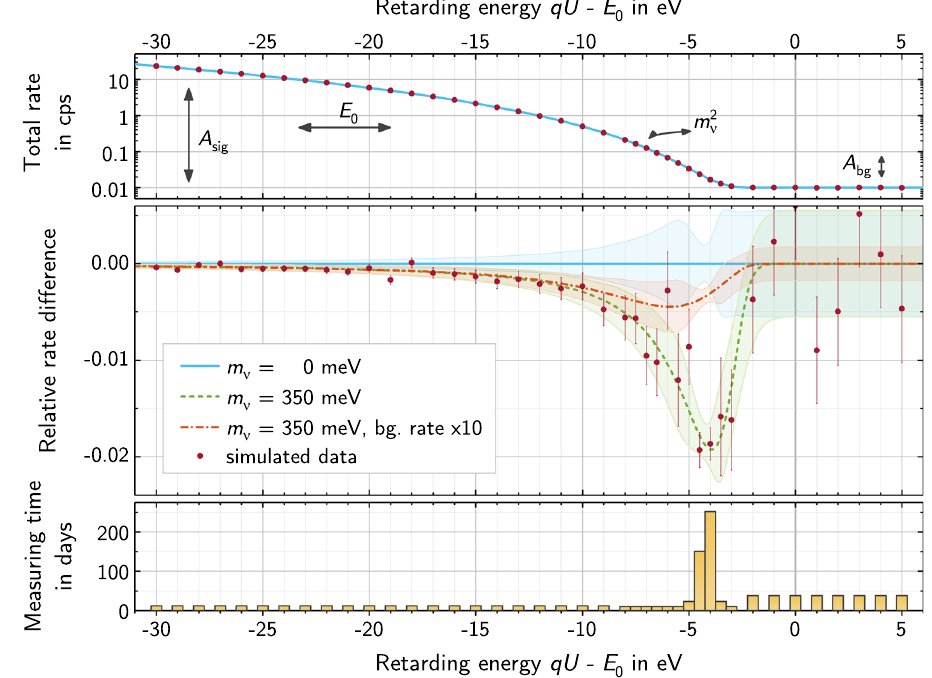
Fig. 20 An illustration of a hypothetical neutrino mass signal, using toy data simulated for m ν = 350 meV (red points + stat. error bars), compared against the theoretical model expectations for m ν = 0 meV (blue solid line), m ν = 350 meV (green dashed line) at nominal back- ground of R bg = 10 mcps, and m ν = 350 meV at elevated background R bg = 100 mcps (orange dash-dotted line). Top panel: The absolute (cid:6) ˙ N ( U ) = N ( U ) is plotted against the retarding energy rate jk k k k j qU k relative to the endpoint energy E 0 . Middle panel: The relative rate difference near the endpoint energy. Under the nominal background